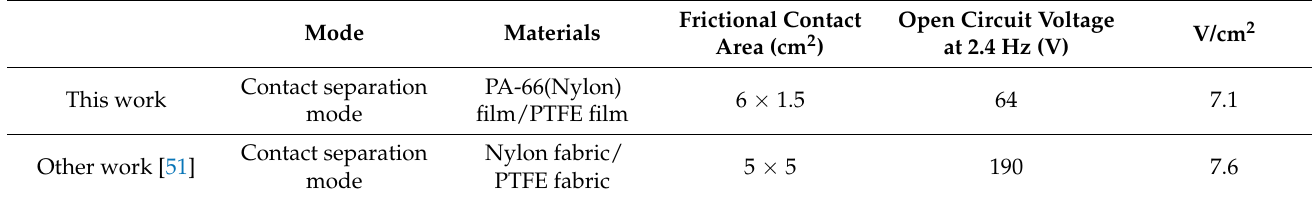
Table 1. Comparison of friction layer